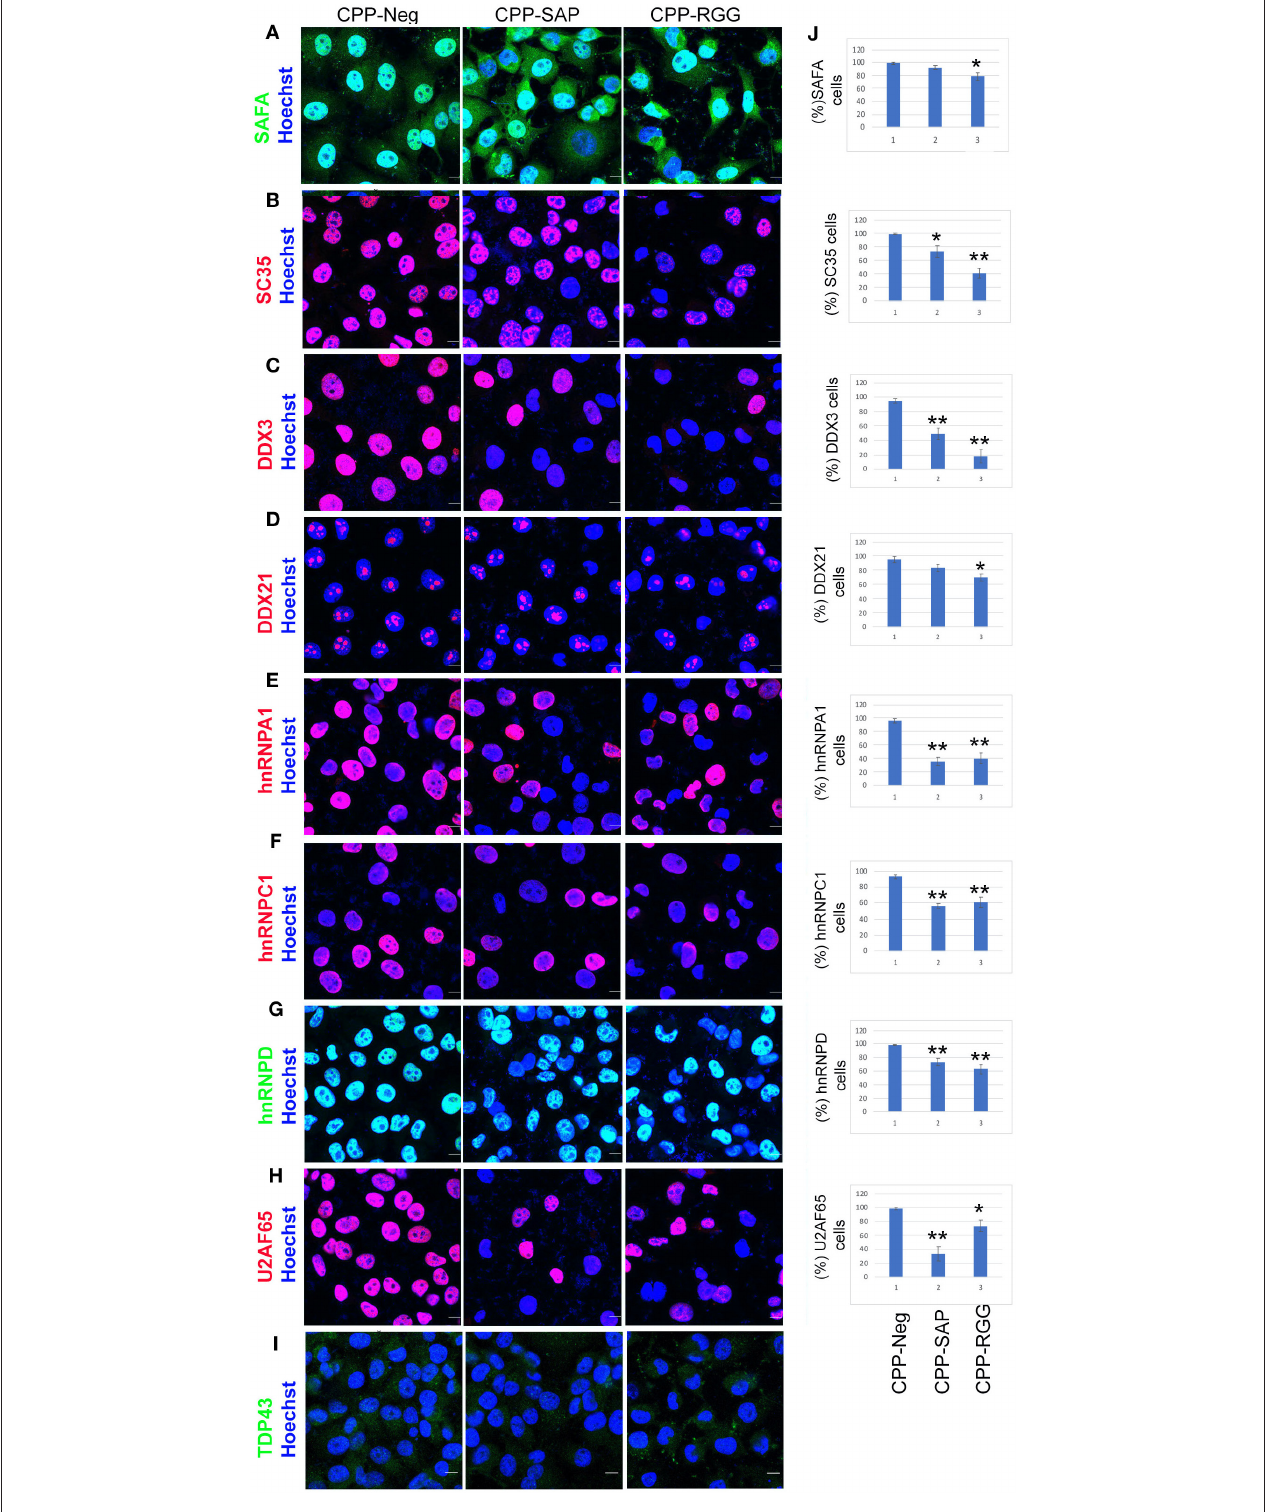
FIGURE 5 | CPP-RGG and CPP-SAP decrease levels of SAFA-interacting spliceosome components. (A–I) Immunofluorescence for spliceosome interactors (red or green signal) and nuclei (Hoechst, blue) in peptide treated HCT116 cells. Scale bar, 10 µ m. (J) Quantification of % of HCT116 cells positive for proteins indicated at left. * p < 0.05, ** p < 0.01 relative to